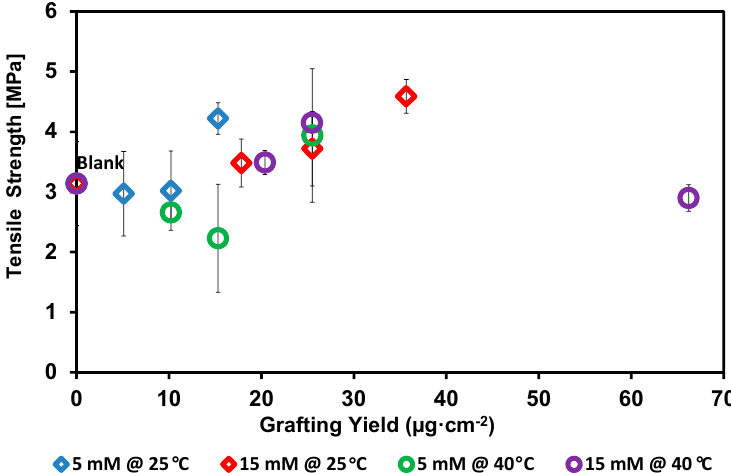
Figure 12. Effect of the grafting yield on the tensile strength of the blank poly(ethersulfone) (PES) membrane. Common reaction condition is pH 5.5 (0.1 M sodium acetate buffer), and 0.5 U·mL − 1 enzyme (laccase). Reaction at 25 °C using 5 mM 2-AP (blue diamond) and 15 mM 2-AP (red diamond), and reaction at 40 °C using 5 mM 2-AP (green circle) and 15 mM 2-AP (purple circle). Resection times 30, 60, and 120 min were tested and the grafting yield was increased with increasing the reaction time.